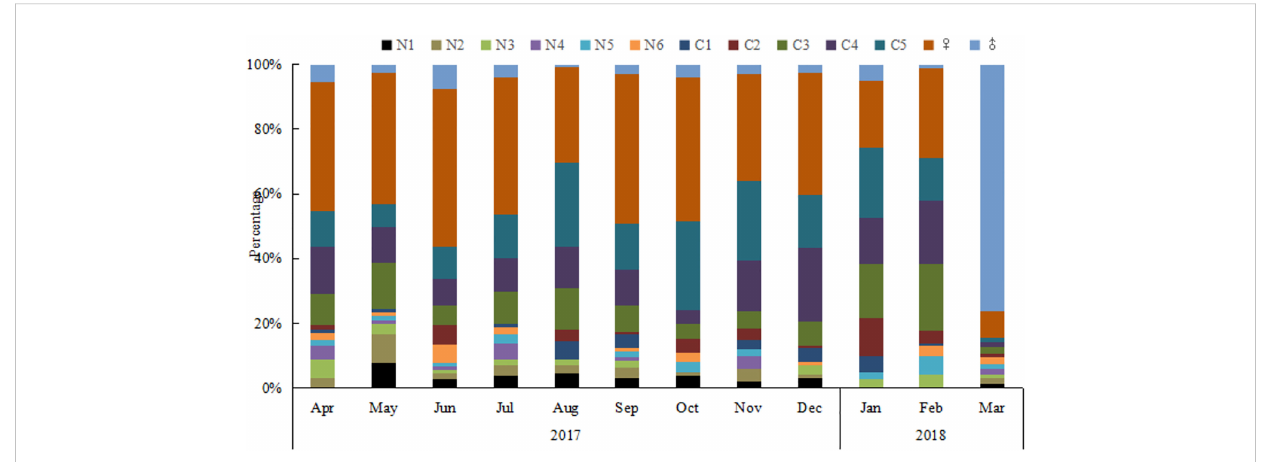
FIGURE 6 Annual compostion of Oithona similis community in Jiaozhou